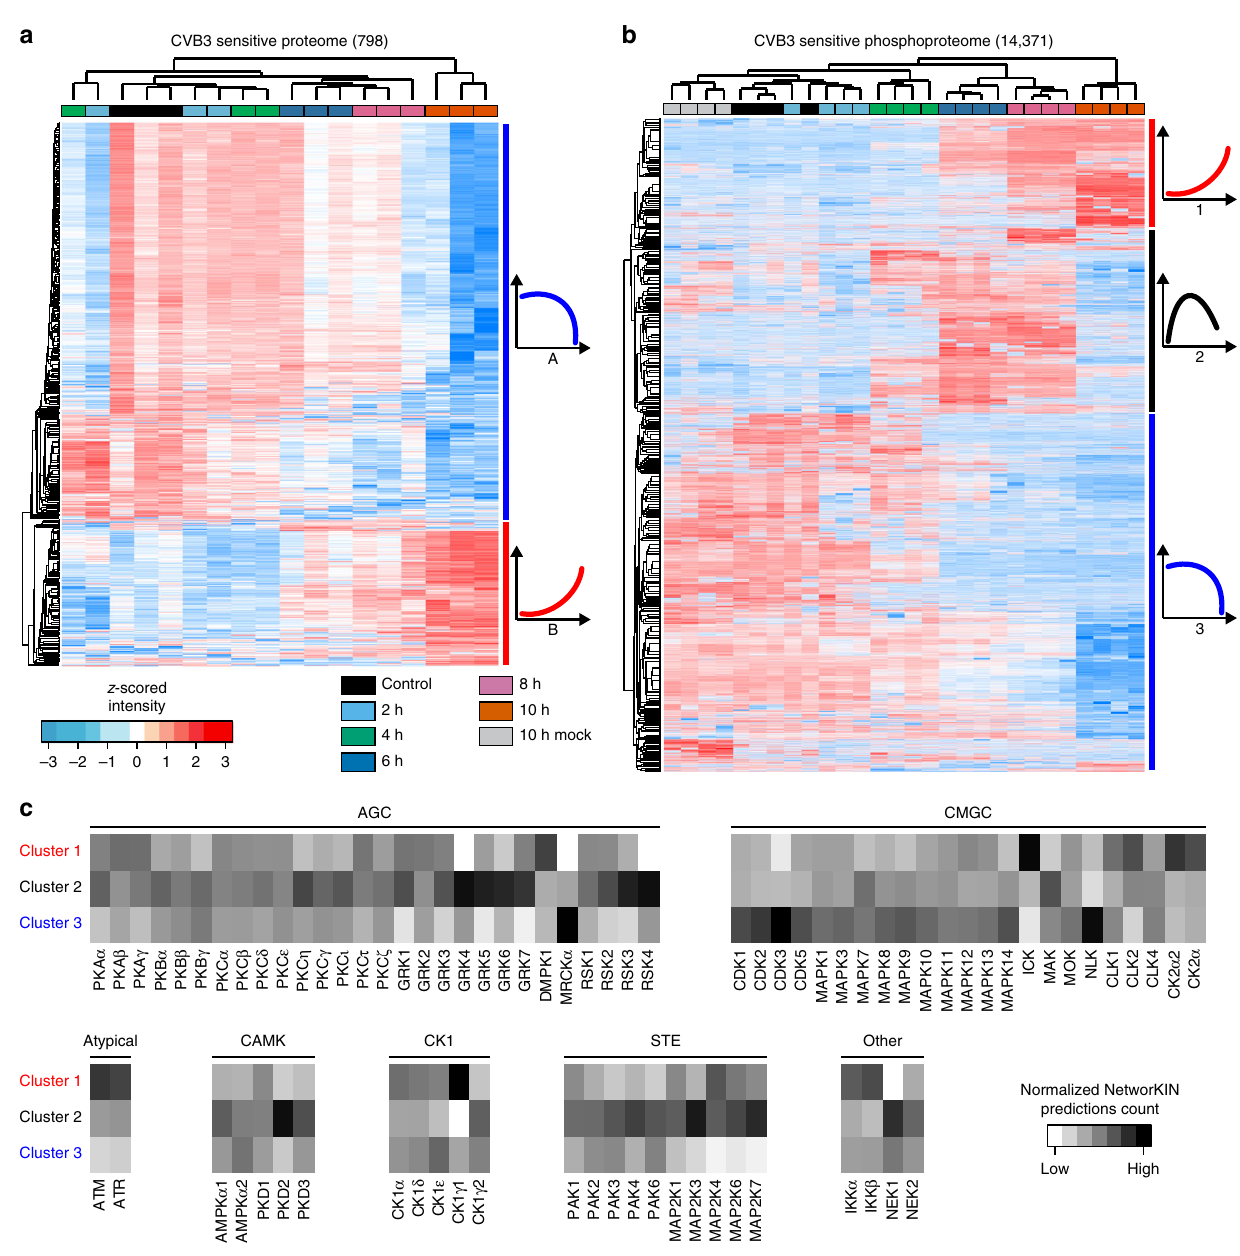
Fig. 2 Dynamic and functional analysis of the (phospho)proteome data. a Heat map of z -scored protein abundances (LFQ intensities) of the proteins differentially expressed through time (ANOVA, FDR < 0.05). The two clusters encompass 587 downregulated proteins (cluster A) and 211 upregulated proteins (cluster B). b Heat map and hierarchical clustering of the z -scored site intensity of 14,371 CVB3-regulated phosphosites (ANOVA, FDR < 0.05). The three clusters discriminate between upregulated (cluster 1), dynamically regulated (cluster 2) and downregulated (cluster 3) phosphosites. c Upstream kinase prediction analysis via NetworKIN of the CVB3-regulated phosphosites suggests that several classes of kinases are activated differently during the progression of the infection. Kinases are grouped based on their families. Source data are provided as a Source Data fi le for all undergoes temporal regulation (Fig. 1d and Source Data File). analysis of the 14,371 signi fi cantly regulated phosphorylation Furthermore, our analysis revealed that protein phosphorylation undergoes the greatest degree of change with a median change of about sevenfold (2.82 2 log) (Fig. 1e and Source Data File), indi- cating that the phosphoproteome is much more dynamic and sensitive to CVB3 infection than the proteome. Our phosphoproteomics analysis cumulatively identi fi ed 17,141 class I phosphorylation sites located on 4428 proteins (~2/3 of the total detected proteome), comprising 25,816 serine (86.4%), 2228 threonine (13%) and 97 tyrosine (0.6%) residues (Supplementary Data 4). We performed a hierarchical clustering